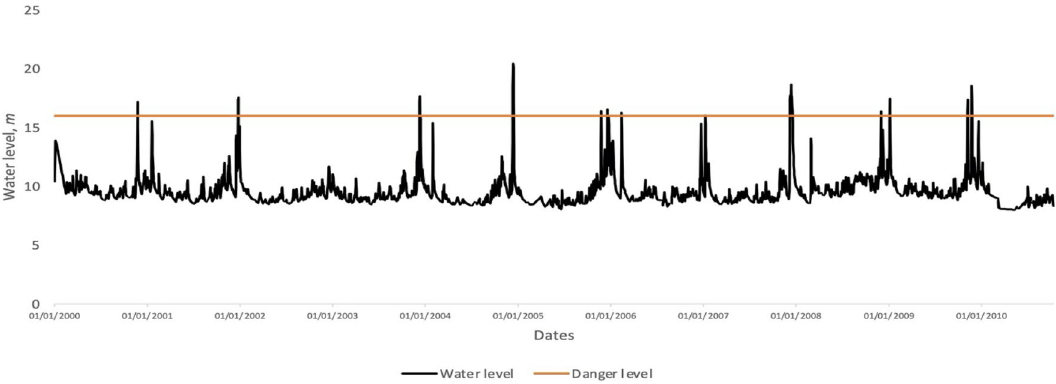
Figure 4. Time series plot of the daily water level data of Kelantan River obtained at Guillemard Bridge station from 01/01/2000 to 13/10/2010.